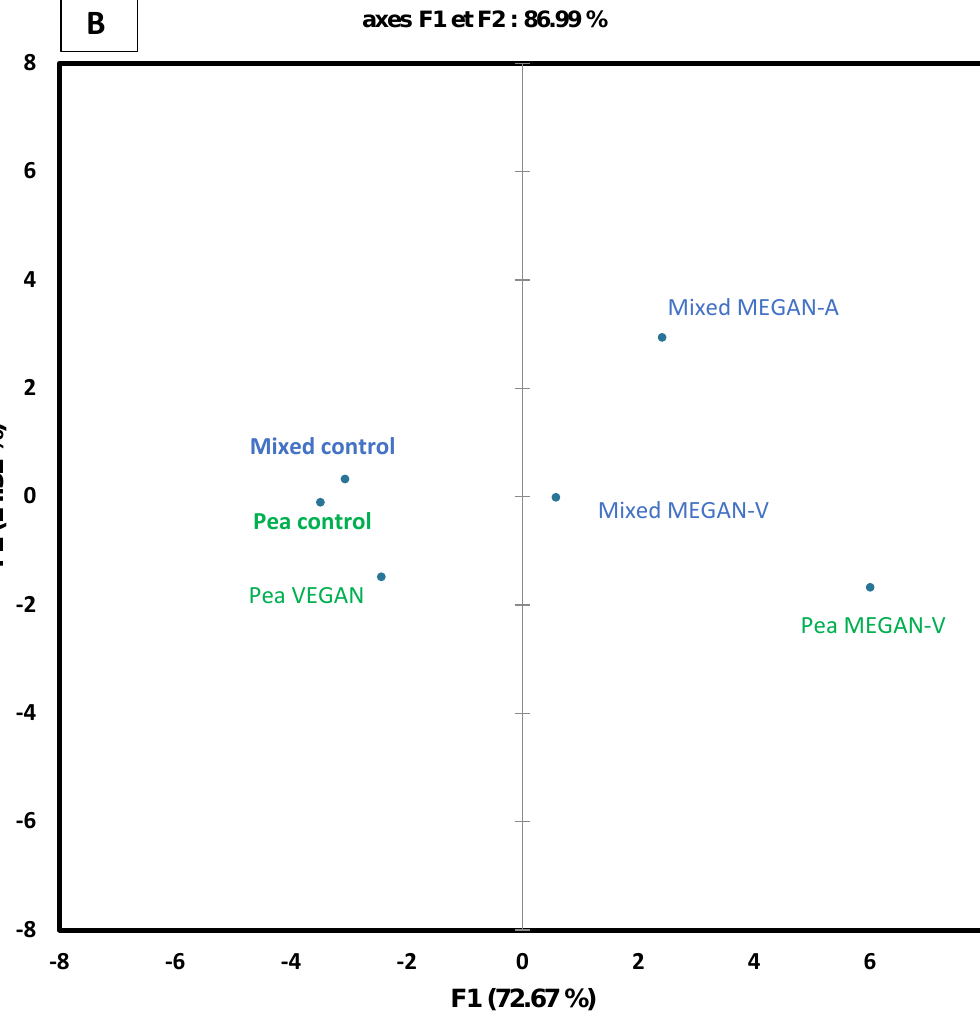
Figure 3. Free amino acid composition of pea and mixed gels: not fermented gel and fermented gel at three days with the different microbial consortia: VEGAN (VEG), MEGAN-A (MEG-A), and MEGAN-V (MEG-V). ( A ) map of amino acids composition, ( B ) map of products: Blue: Mixed gels, Green: Pea Gels.